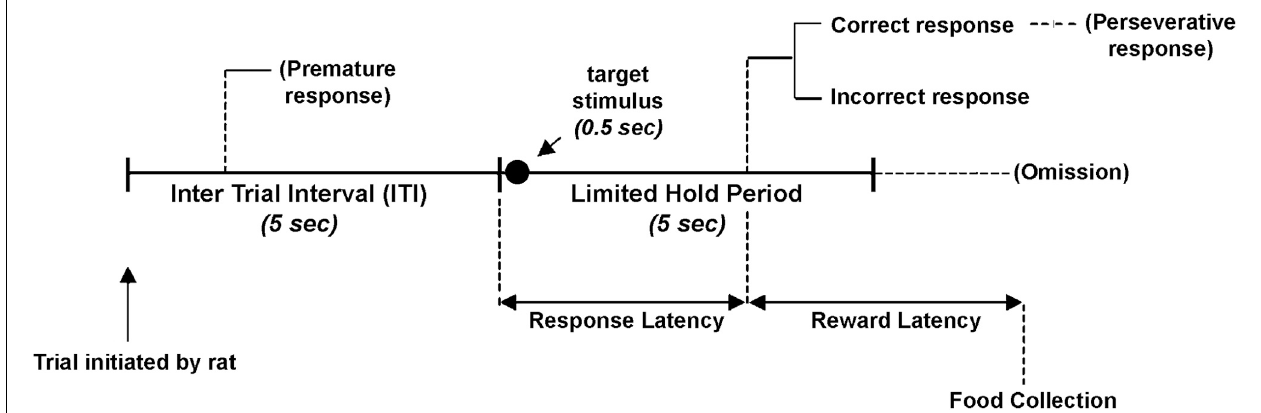
FIGURE 1 | Schematic diagram of the 5-choice serial reaction time task. After a waiting period of 5s (ITI) a target stimulus is presented for 0.5s in one of the five apertures in a random order. The rat is allowed to make its choice to respond correctly or incorrectly. After a correct nose-poke in one of the